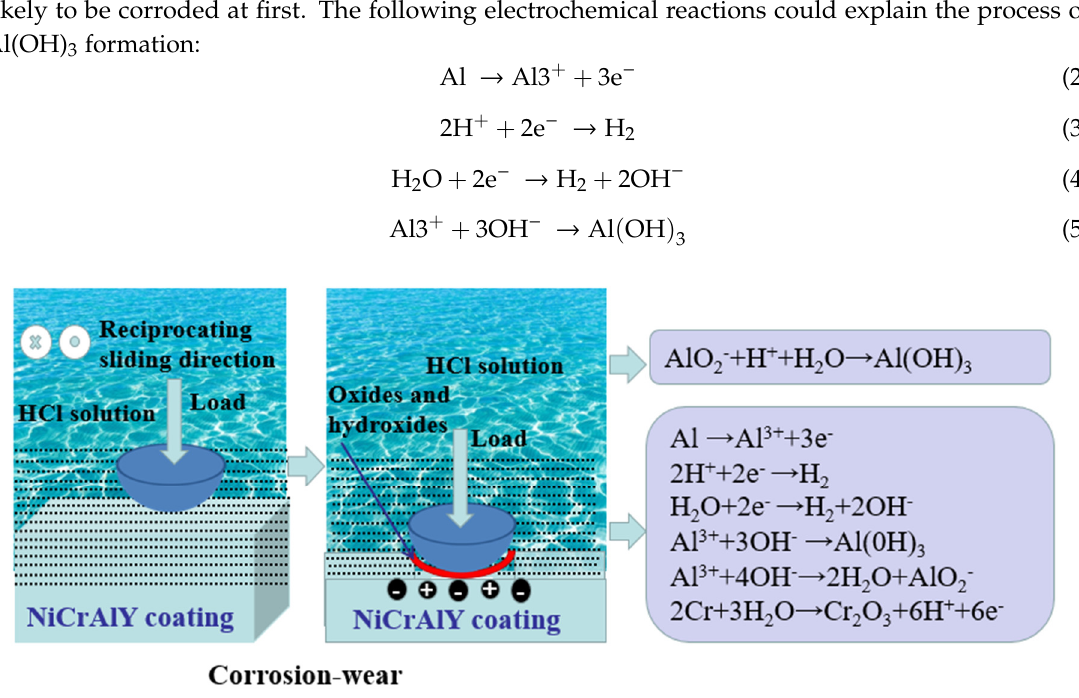
Figure 8. Schematic diagram of corrosion-wear mechanisms of NiCrAlY coating in HCl solution.